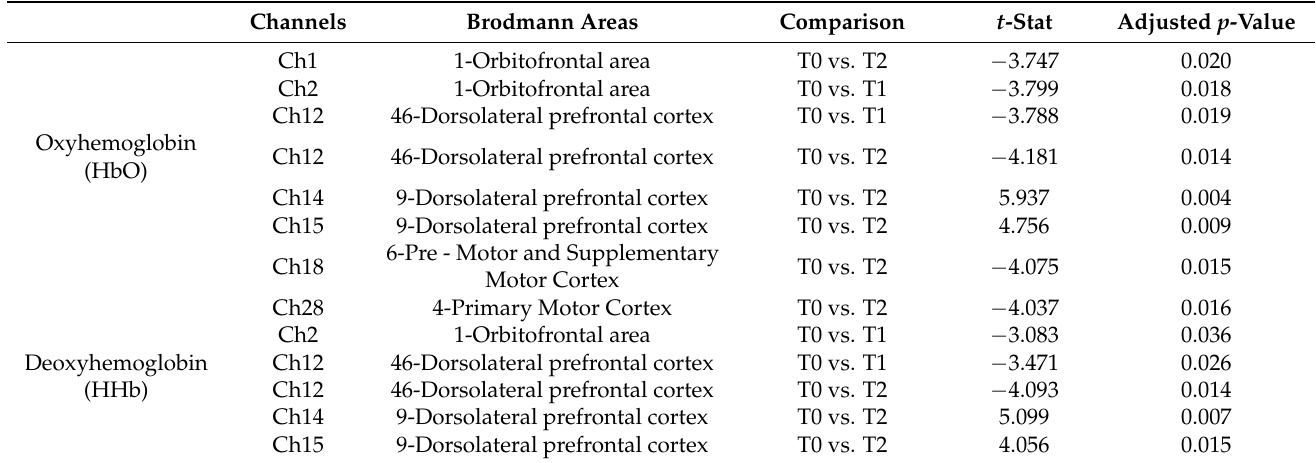
Table 4. Multiple comparisons (paired t -test) associated with the RM-ANOVA. Only significant comparisons were reported in the table.